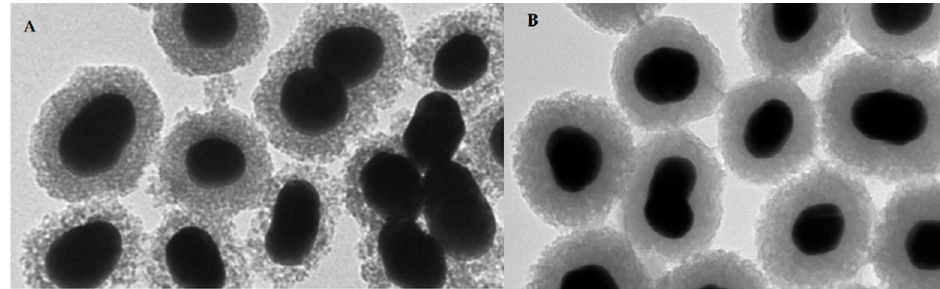
Figure 9. Representative image of PET-SERRS nanoparticles with non-optimized 68 Ga-labeling ( A ) with visible degradation of silica shells and after the optimization ( B ) with improved stability of the silica shells [118].